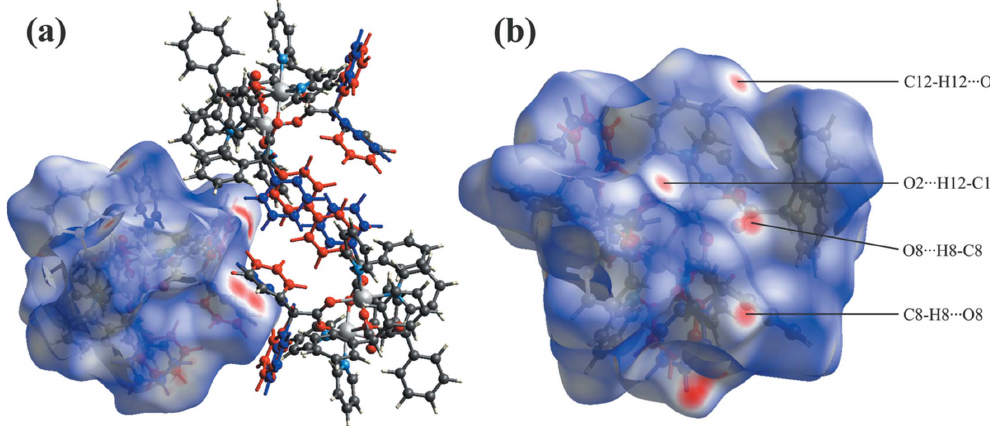
Figure 5 The Hirshfeld surface mapped over d norm for compound 1 in the range (cid:3) 0.4078 to 1.4837